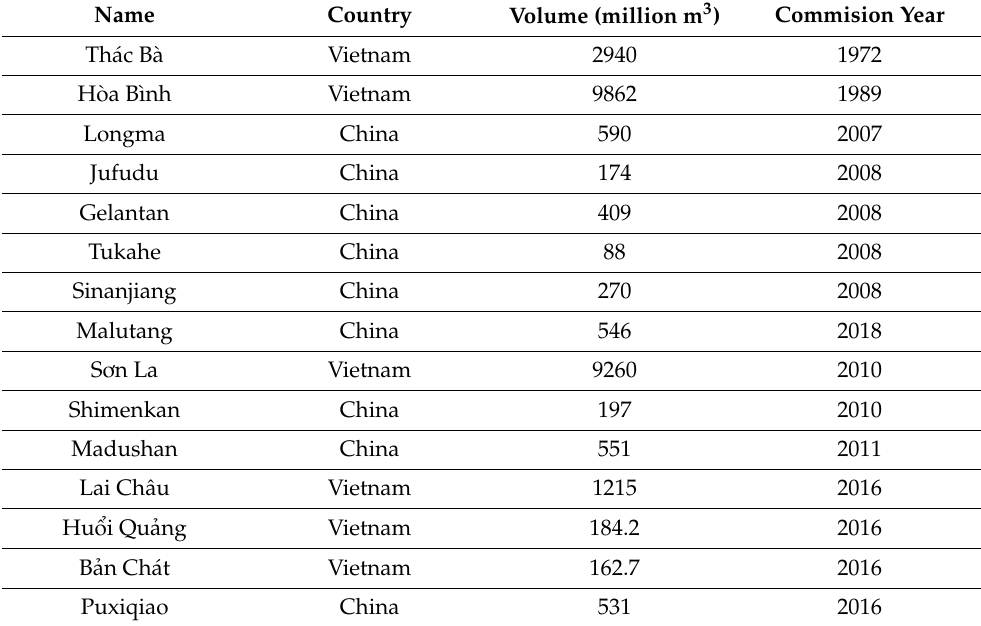
Table 1. Main reservoirs in the Red River system